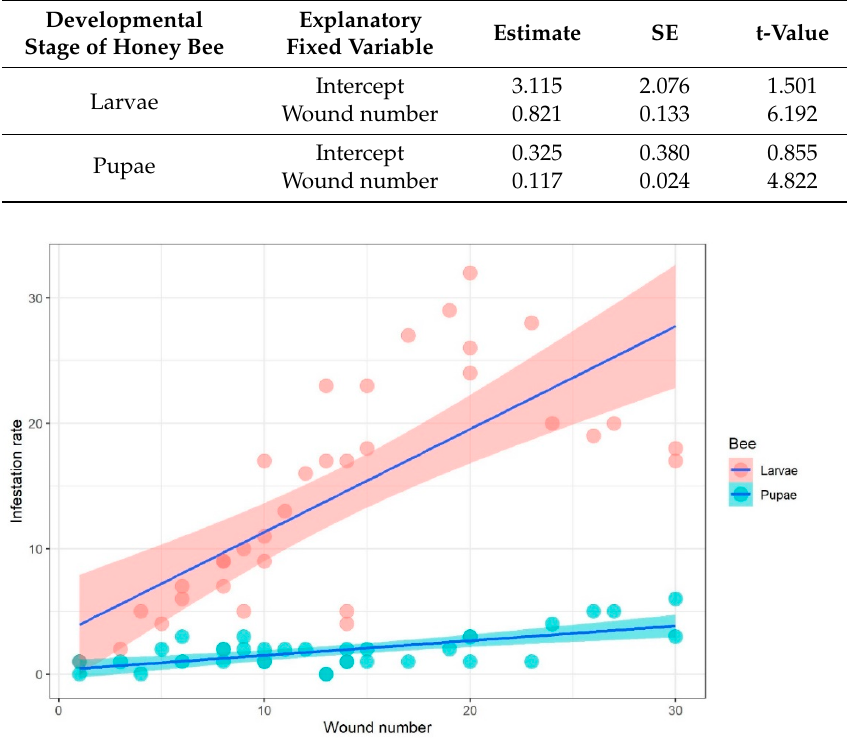
Figure 2. The relationship between the infestation rate of Tropilaelaps mercedesae mites and the number of injuries that occurred in each of the larval and pupal stages of honey bee Apis mellifera . Pink and cyan circles represent the infestation rate for each of the injury numbers of bee larvae and pupae. Blue solid lines with pink and cyan curves show the significant relationship between mite infestation rate and injury numbers of bee larvae and pupae using linear regression.